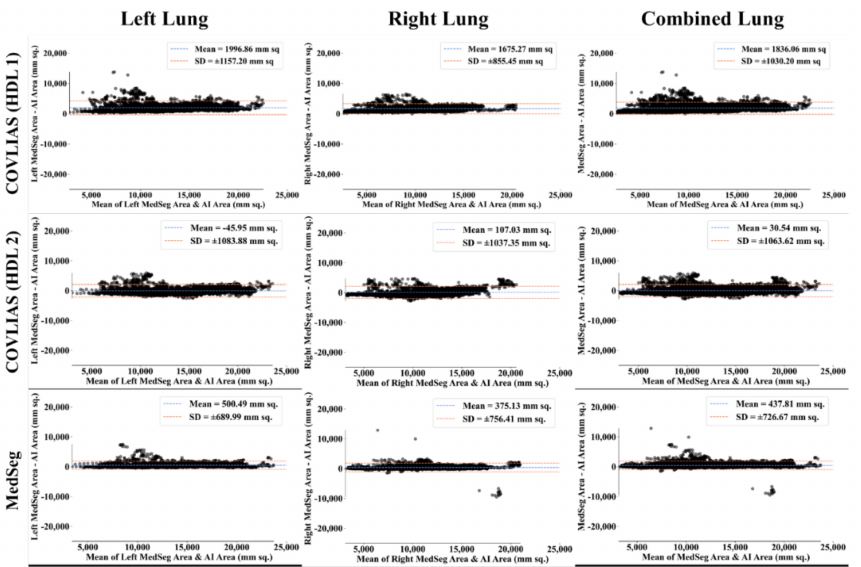
Figure 11. Bland–Altman plots: COVLIAS (row 1 and row 2) vs. MedSeg (row 3) using MD 1. Column 1: left lung, column 2: right lung, and column 3: mean of left and right. COVLIAS (HDL 1): VGG-SegNet; COVLIAS (HDL 2):